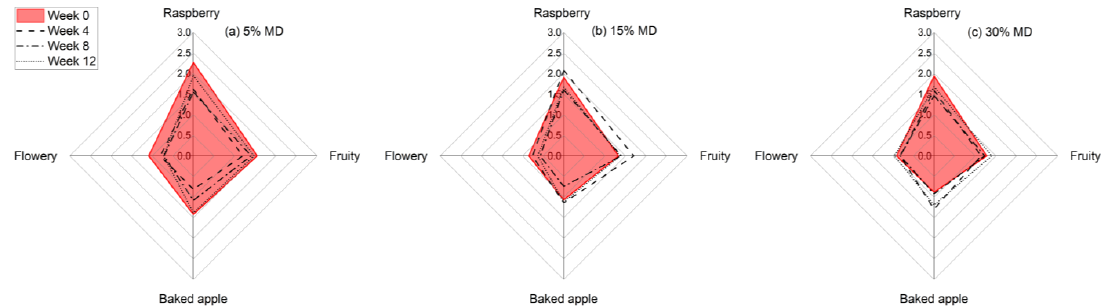
Figure 6. Diagram showing the average sensory ratings for the dried raspberry foam samples with 5% ( w / w ) PP + 2.5% ( w / w ) P at various MD concentrations, i.e., ( a ) 5% MD, ( b ) 15% MD, and ( c ) 30% MD, over a 12-week storage period.